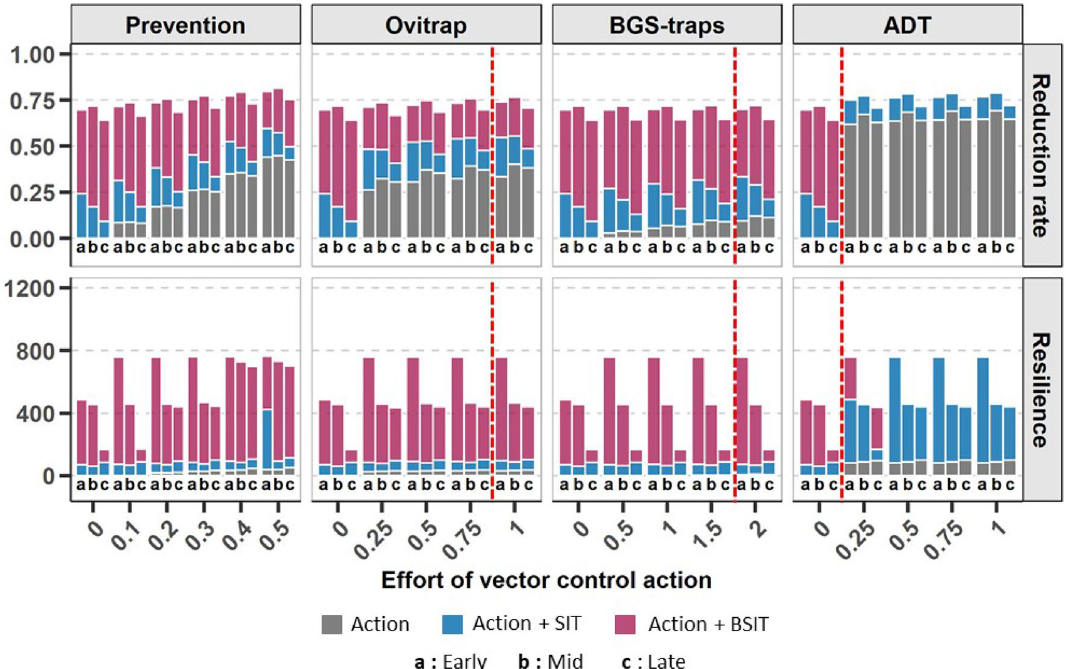
Figure 4. Reduction rate and resilience in the tropical climate for an increasing effort in vector control actions against Aedes albopictus . Vector control actions (ovitraps, BGS-traps, ADT and prevention) are represented by grey bars. The benefits added by combining them with (1) SIT (releases of 1000 males/ha) and (2) BSIT (releases of 1000 males/ha) are represented by pink and blue bars, respectively. The effort devoted to each control action is indicated, either as a rate of breeding sites destroyed for prevention, or as the number of traps/stations per house for ovitraps, BGS-traps and ADT. Three control periods were tested: early in the year (Early) when the mosquito population is low, midway in the year (Mid) when the population is increasing, or later in the year (Late) when the population reaches its maximum. The vector control actions were simulated on a mean weather dynamic and outputs were averaged among the 4 studied parcels (see “Methods”). The red dashed lines indicate the number of ovitraps, BGS-traps or ADT stations required to reach the plateau of maximum effect for the action performed